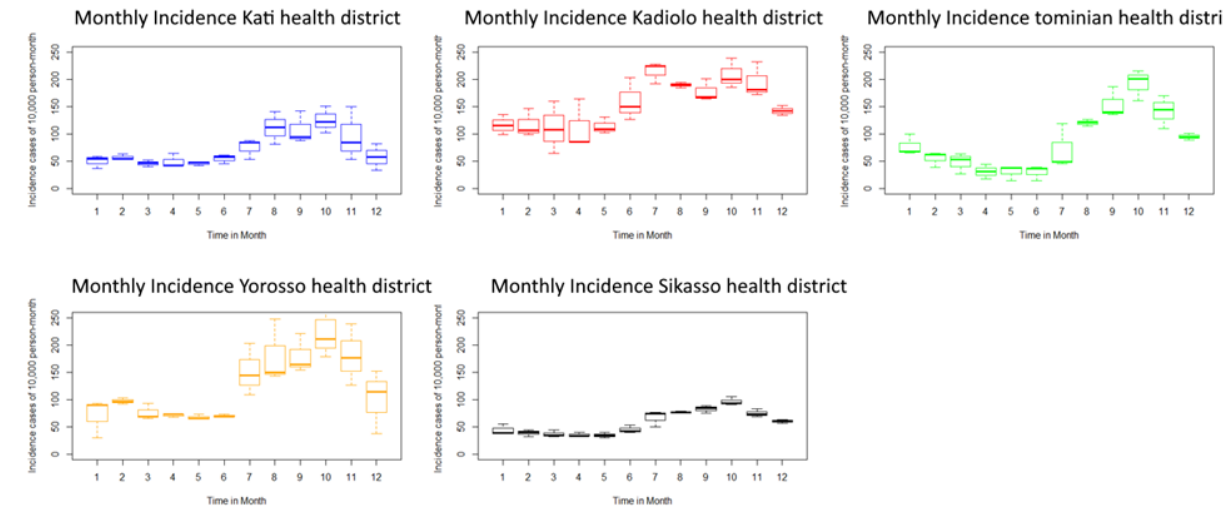
Figure 2. Average monthly malaria incidence by health district from 2016 to 2018 for 10,000 pers.